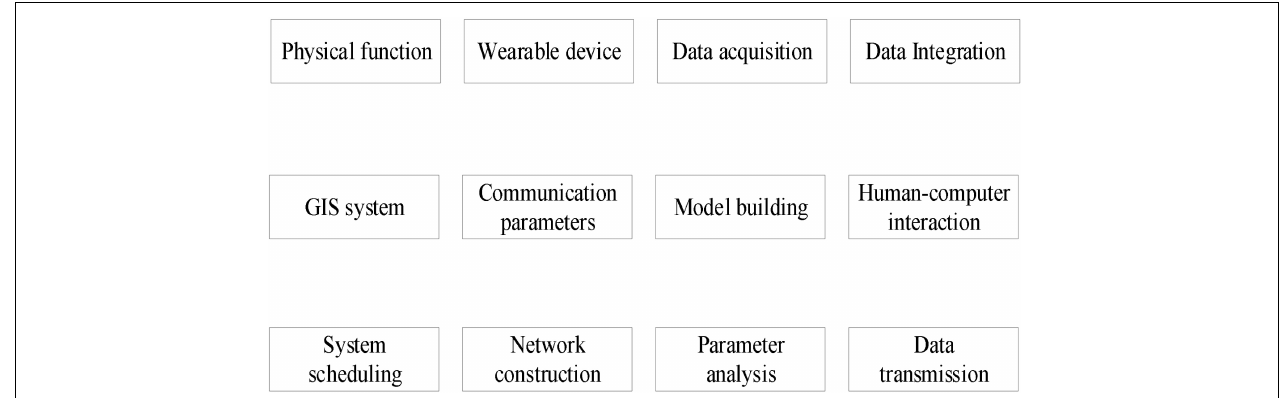
FIGURE 3 | Structure chart of sport mental health pattern recognition.